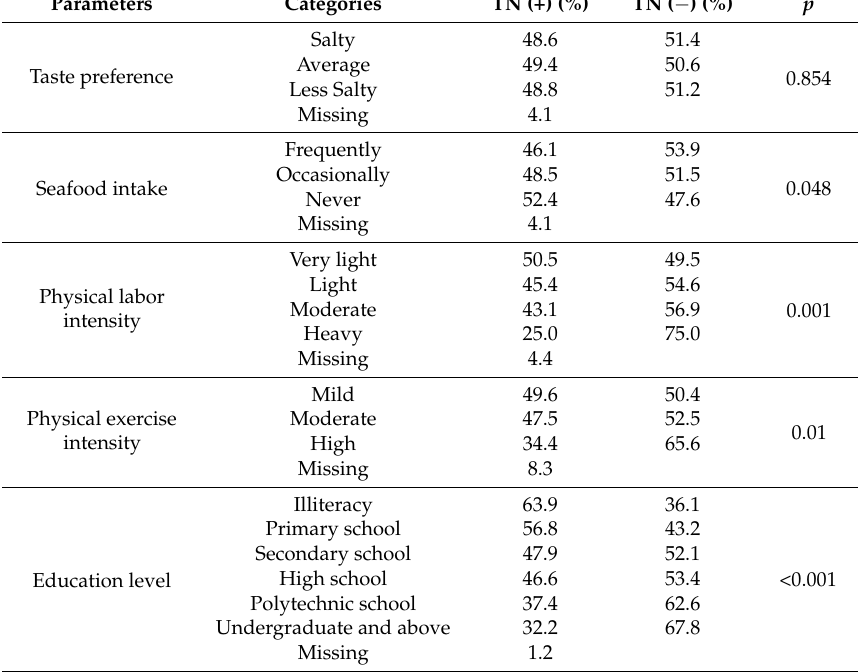
Table 4. Comparison of the prevalence rates of thyroid nodules in different lifestyle